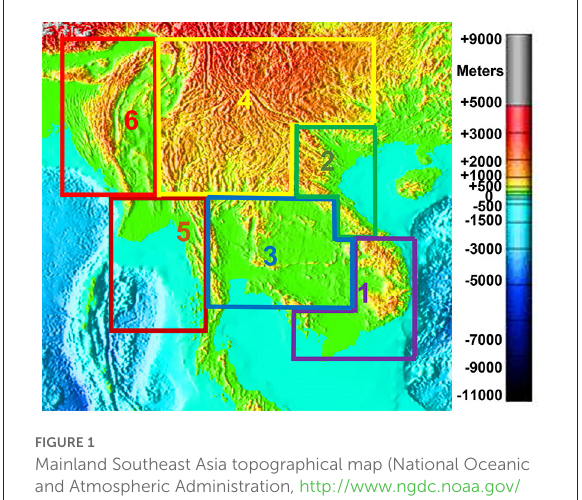
FIGURE1 Mainland Southeast Asia topographical map (National Oceanic and Atmospheric Administration, http://www.ngdc.noaa.gov/ mgg/image/2minrelief.html) based on ETOPO2v2 topography/bathymetry 2-minute dataset: [NOAA National Geophysical Data Center. 2006: 2-minute Gridded Global Relief Data (ETOPO2) v2. NOAA National Centers for Environmental Information. https://doi.org/10.7289/V5J1012Q. Accessed (1/10/2019)]. The 6 sub-regions for which area-averaged mean and extreme precipitation changes are investigated here are also depicted: (1) South Vietnam, (2) North Vietnam, (3) Central MSEA, (4) North MSEA, (5) South Myanmar, (6) Northwest